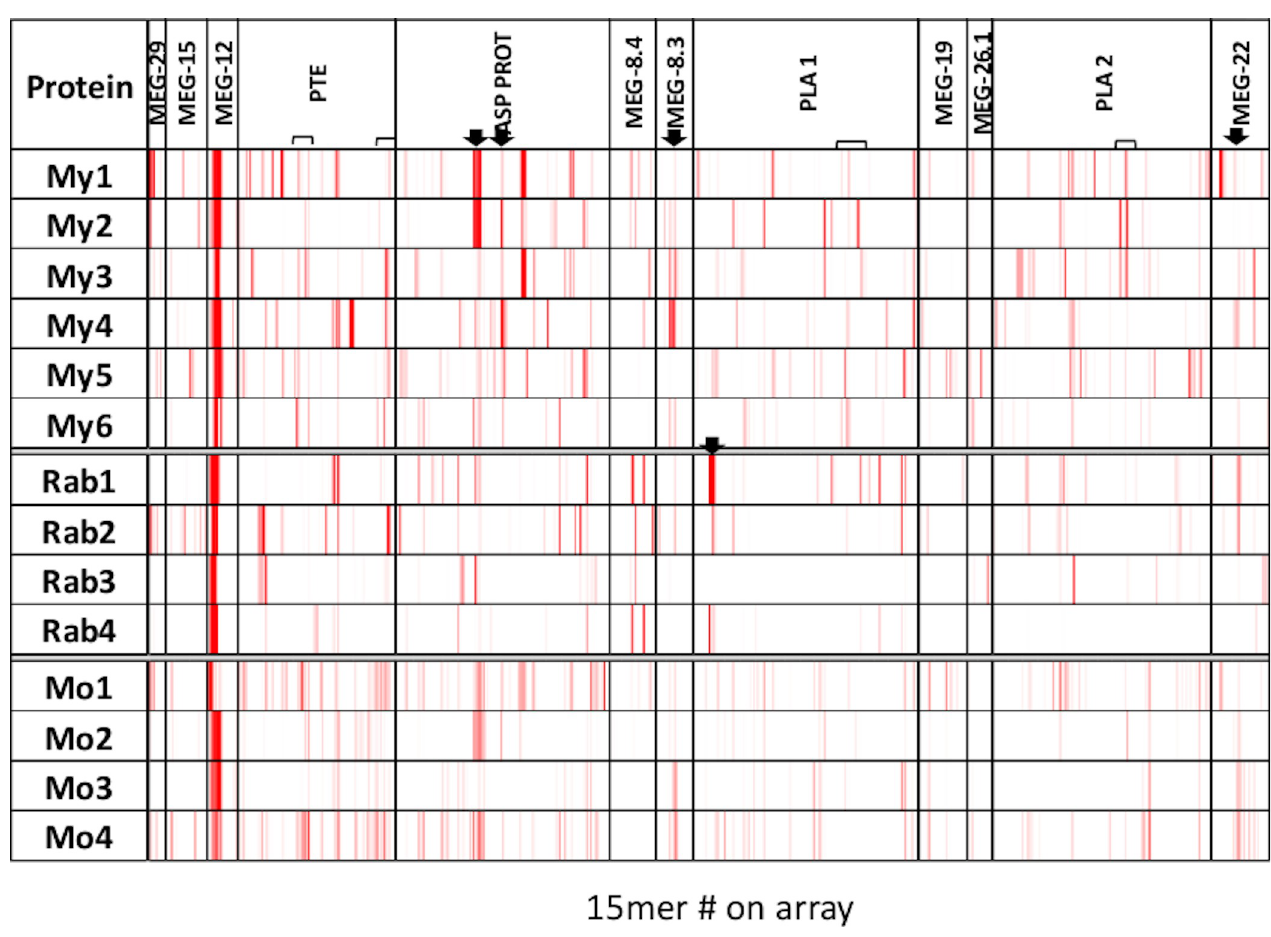
Fig 5. Heatmap of Array 2. The array was reacted with six macaque (My) four rabbit (Rab) and four mouse (Mo) infection sera, at 1:100, 1:200 and 1:1000 dilution, respectively. Location of the protein targets represented on the array by overlapping 15mer peptides is shown on the header. The heatmap is plotted on a scale of 1000 to